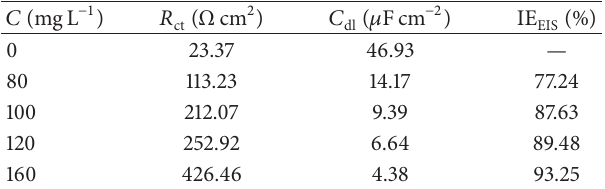
Table 3: The electrochemical parameters of impedance and corre- sponding corrosion inhibition efficiencies or carbon steel in 0.5 M